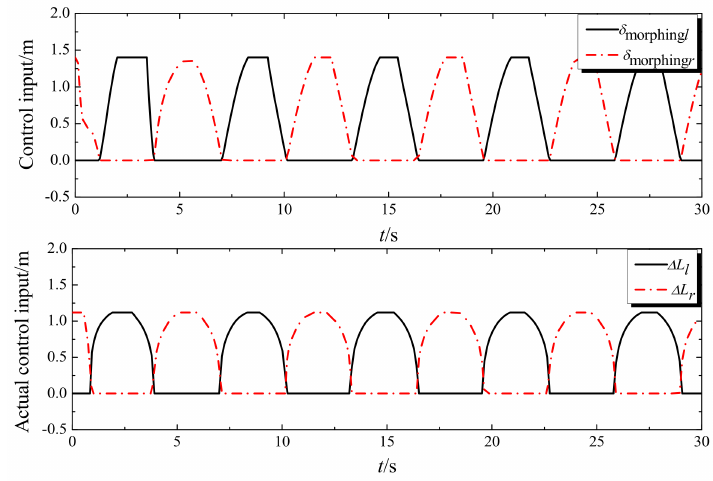
Figure 9. The control input due to morphing motion.